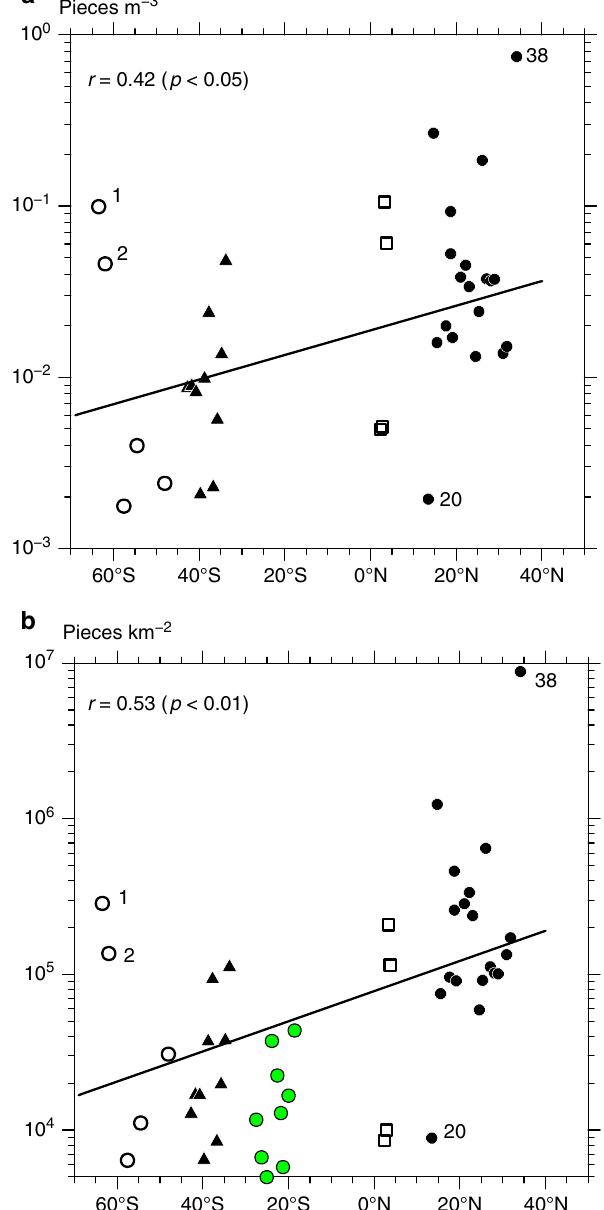
Fig. 3 Abundance of microplastics along the meridional transect. Panel a shows concentrations in the Southern Ocean (open circles), Tasman Sea (closed triangles), Equatorial Paci fi c (open squares), and North Paci fi c (closed circles), while b is the same but for total particle counts. The digits 1, 2, 20, and 38 by the marks denote the station numbers. The regression lines between locations versus microplastic abundance on a log 10 -scale are shown in each panel with the correlation coef fi cient ( r ) and con fi dence level (e.g., p < 0.05 means 95%) suggested by a t test. The estimates provided by Reisser et al. 22 are given in b (green dots) and show that the different surveys also suggest a remarkable meridional contrast, i.e., an abundance in the South Paci fi c that was one order of